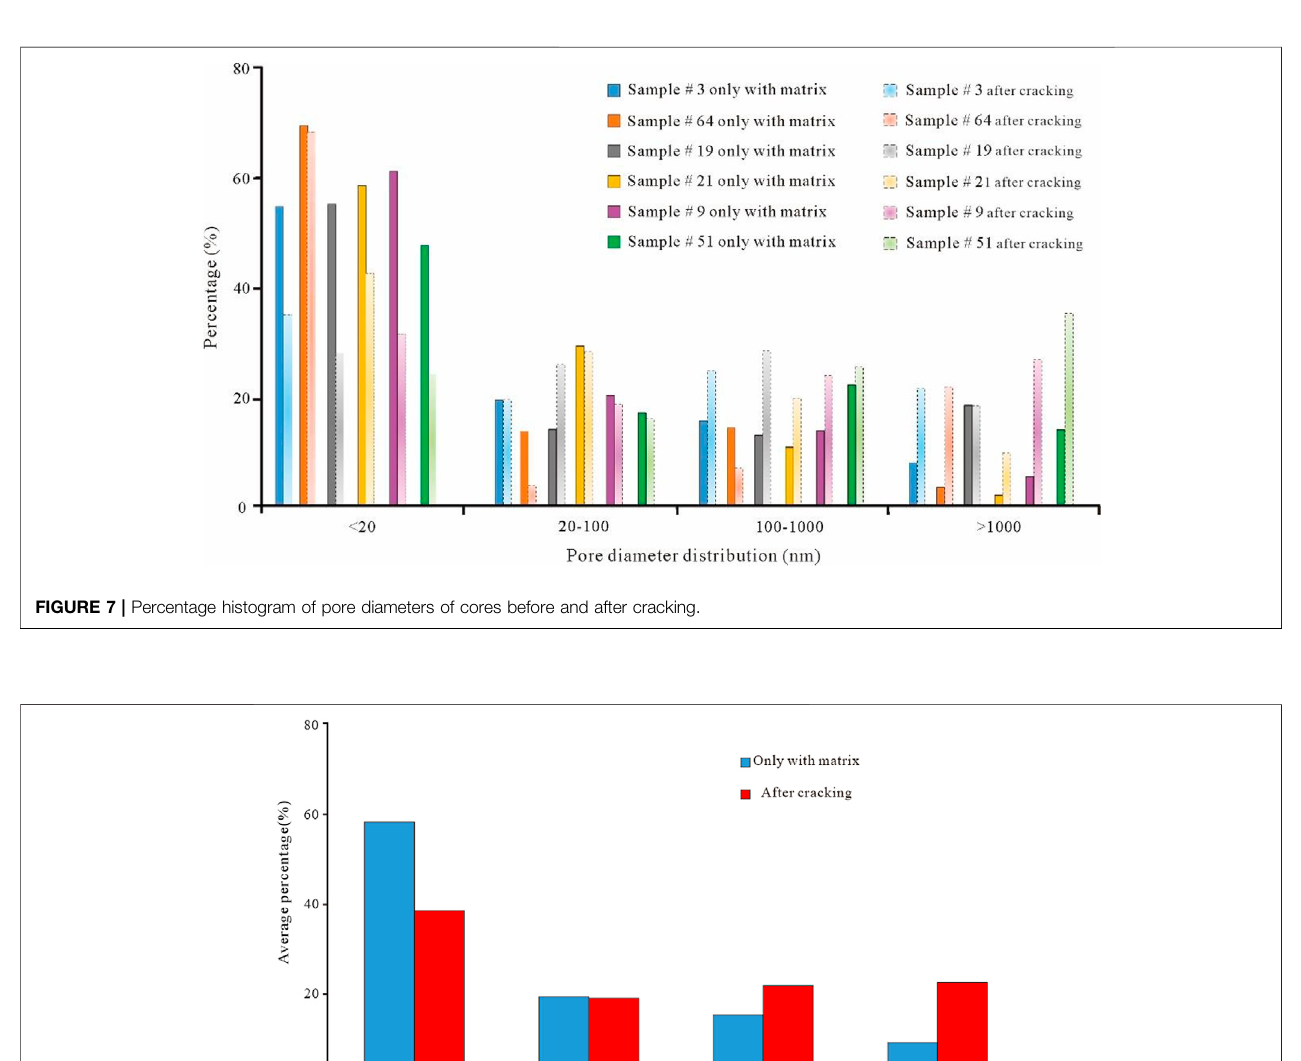
Frontiers in Earth Science |